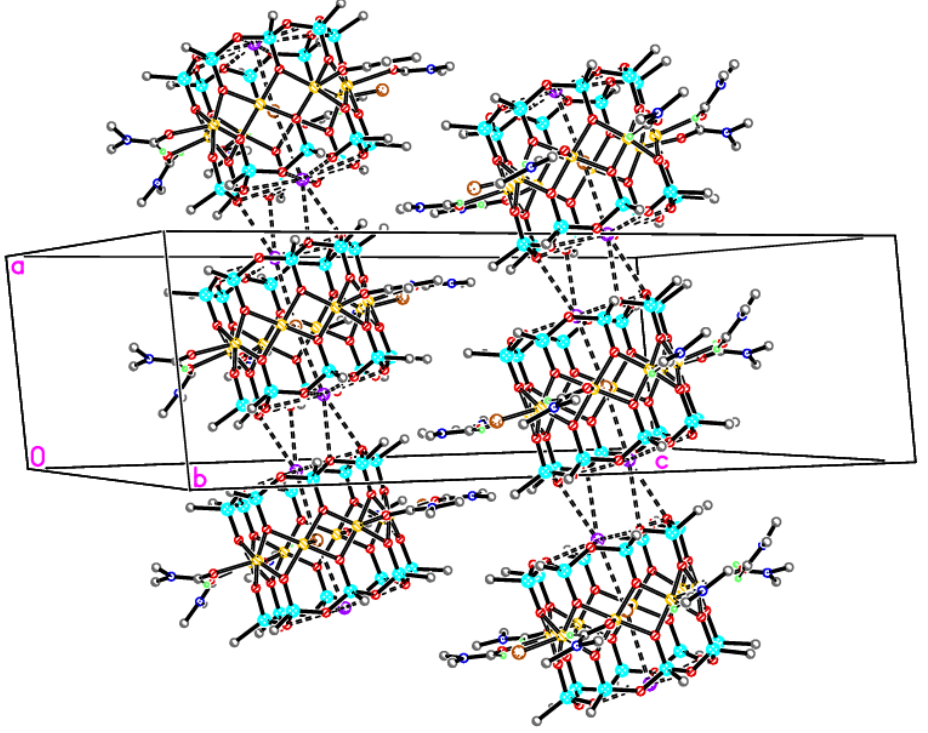
Figure 7. 1D coordination polymer structure of 4 via crown ether contacts of cesium and oxygen atoms of neighboring cages in crystal packing.